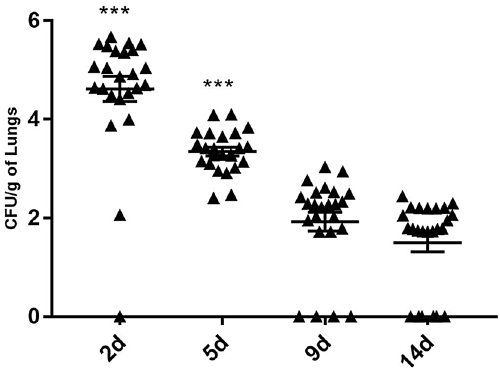
Figure 3. Assessment of the fungal clearance in lungs infected with Cladosporium cladosporioides . The fungal burden in lung homogenates were determined on days 2, 5, 9, and 14 post-inoculation. Data are representative of three independent experiments (n = 8 mice per group). * p < 0.05; ** p < 0.01; *** p < 0.001.